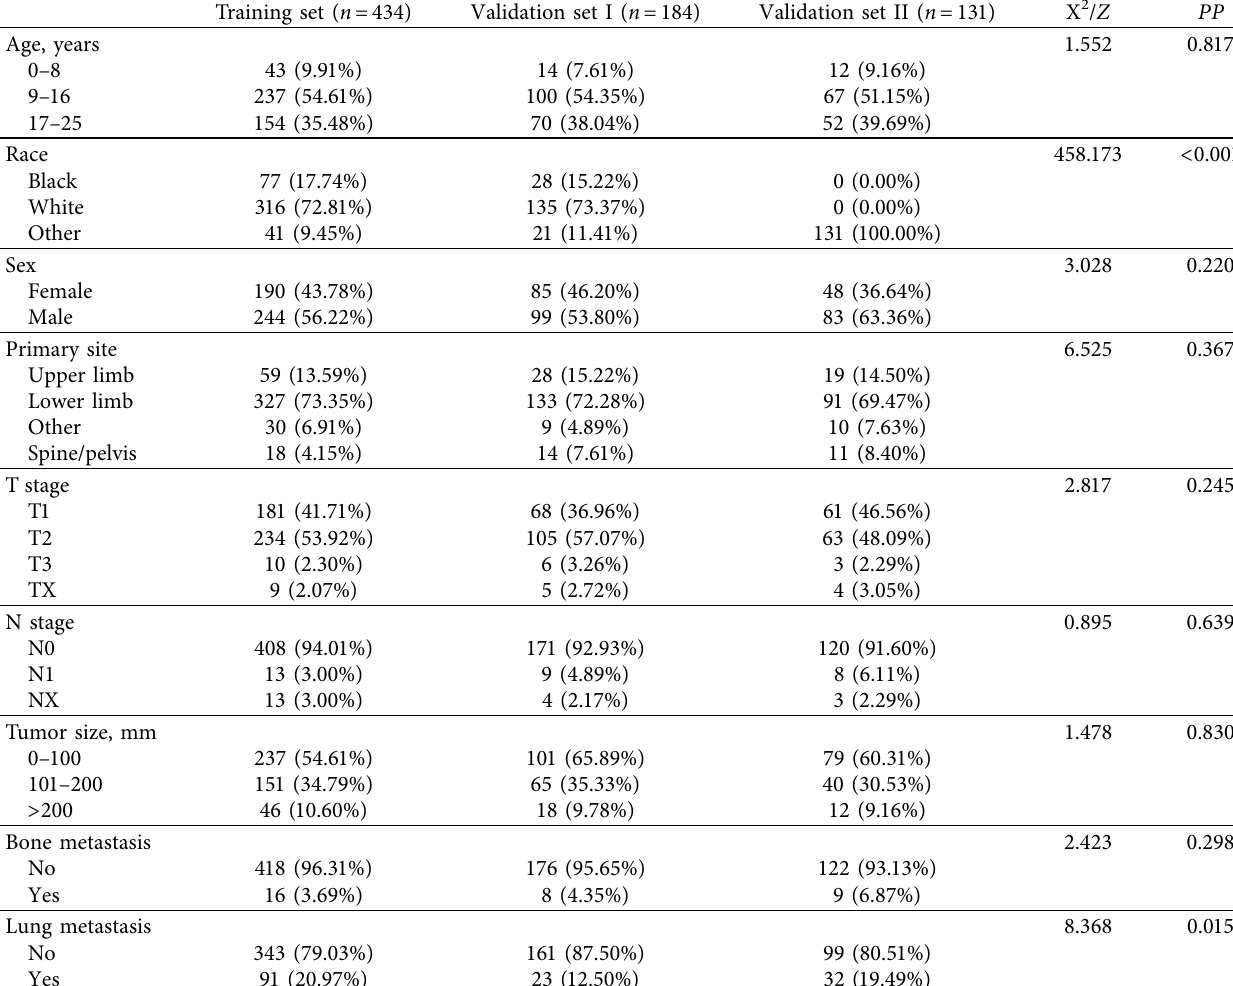
Table 1: Clinical characteristics of osteosarcoma patients.